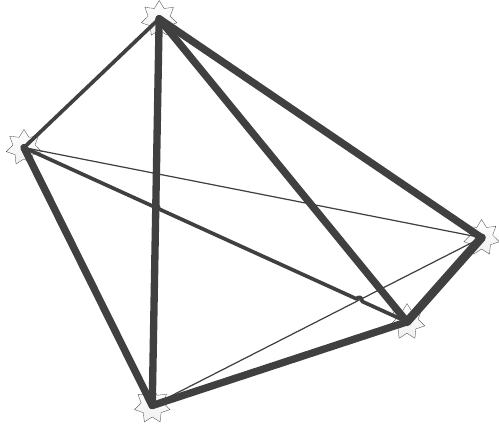
Figure 9. Landmark